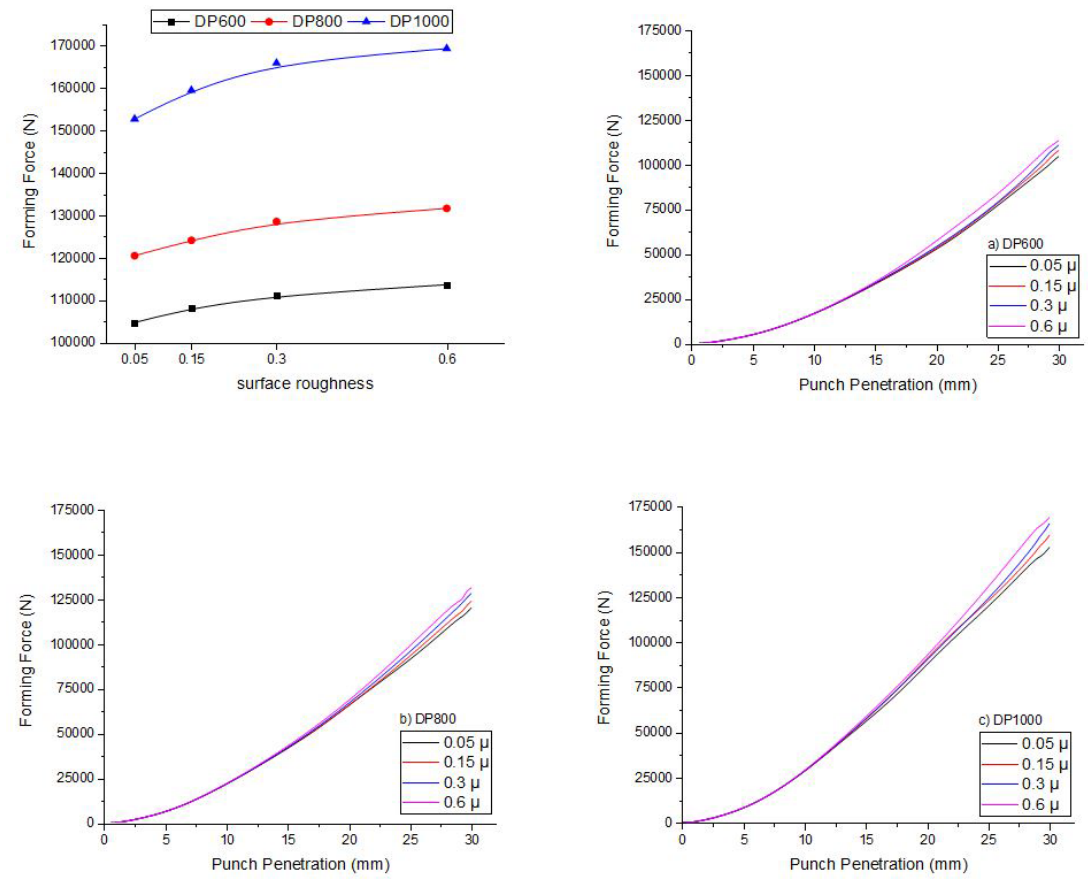
Figure 5. Forming force - friction coefficient relation